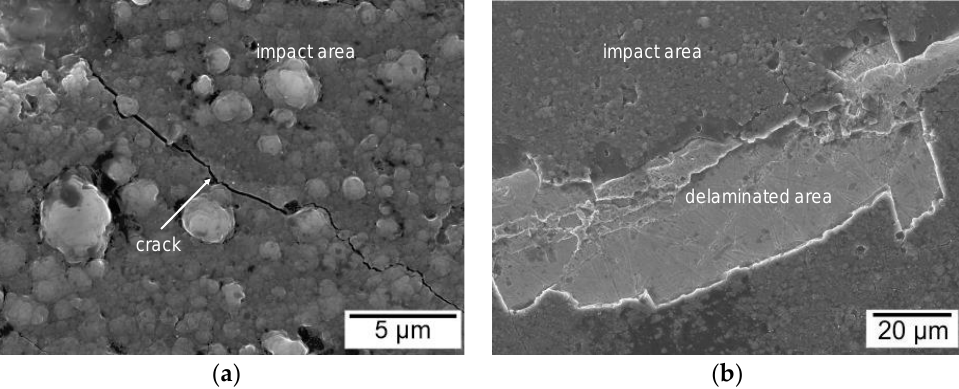
( a ) ( b ) Figure 11. Failure patterns in the outer edge of the impact zone for St-B-C: ( a ) Impact area and crack for the impact created at 2 kN and 1 load cycle; ( b ) Outer edge of the impact zone with significant crack patterns and coating delamination after being subject to 10 5 cycles at 4 kN. The damage evolution predominantly evolved at the pile-up of the impact zone. Therefore, selected cross sections of typical pile-up areas are presented in Figure 12. In Figure 12a, the pile up of a St-C specimen loaded with 3 kN for 10 5 cycles is illustrated. The substrate shows a smooth surface, and the coating is completely connected to the substrate, even in the areas of maximum plastic deformation. It can therefore be concluded that the ta-C coating has evidently an excellent adhesive strength. However, the plastic deformation led to high tensile stresses in the surface of the coating and caused several cracks in the ta-C. There were no cracks or any other signs of defects in the substrate. In contrast, the boride layer of the hybrid coating system shows multiple cracks in the pile-up zone of the impact. Those cracks were already observed after one load cycle up to 3 kN and caused cracks in the ta-C layer (Figure 12b). The size and number of those cracks increased by an increasing number of load cycles (Figure 12c). In comparison to the St-C system, the St-B-C system showed more and larger cracks in the ta-C coating at the same load levels, although the plastic deformation was significantly smaller. The cracks in the ta-C coating could be a result of cracks in the boride layer. Additionally, there were several internal defects and pitting visible in the boride layer. No spalling of the coatings was visible in the cross sections.